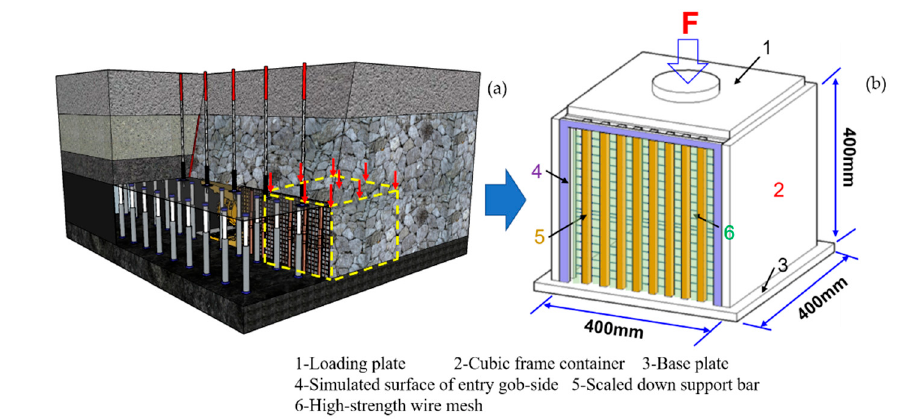
Figure 2. Design principle of the innovative experimental device: ( a ) Schematic diagram of the structure of the GERRF method; ( b ) The structural composition of the experimental device.